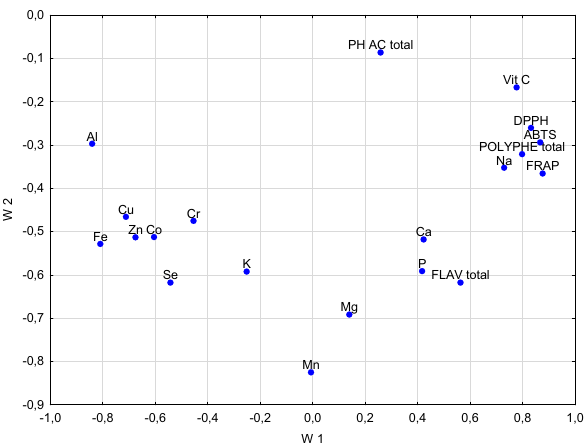
Figure 2: Loading plot obtained for PCA results of African medicinal